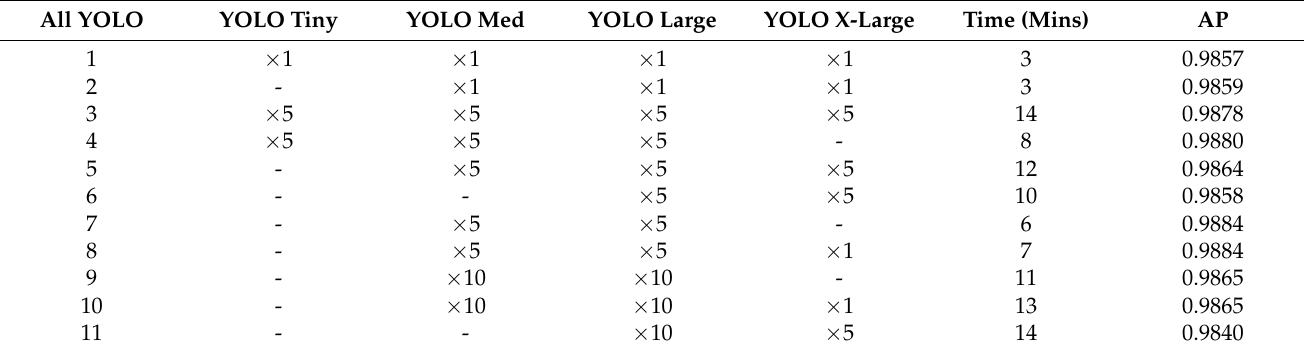
Table A3. Composition and AP values of ensembles comprising only YOLO detectors.